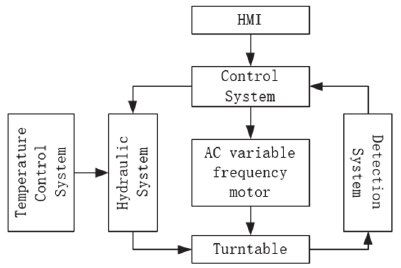
Figure 7. Heavy duty hydrostatic turntable test system working principal diagram.